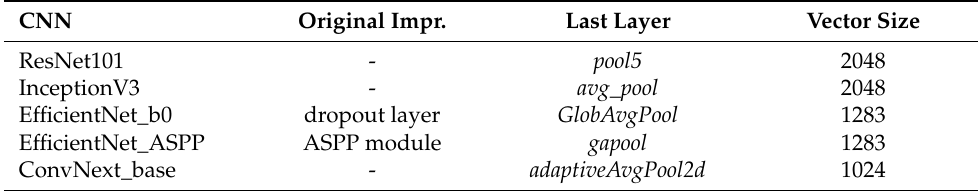
Table 2. The description of the CNN